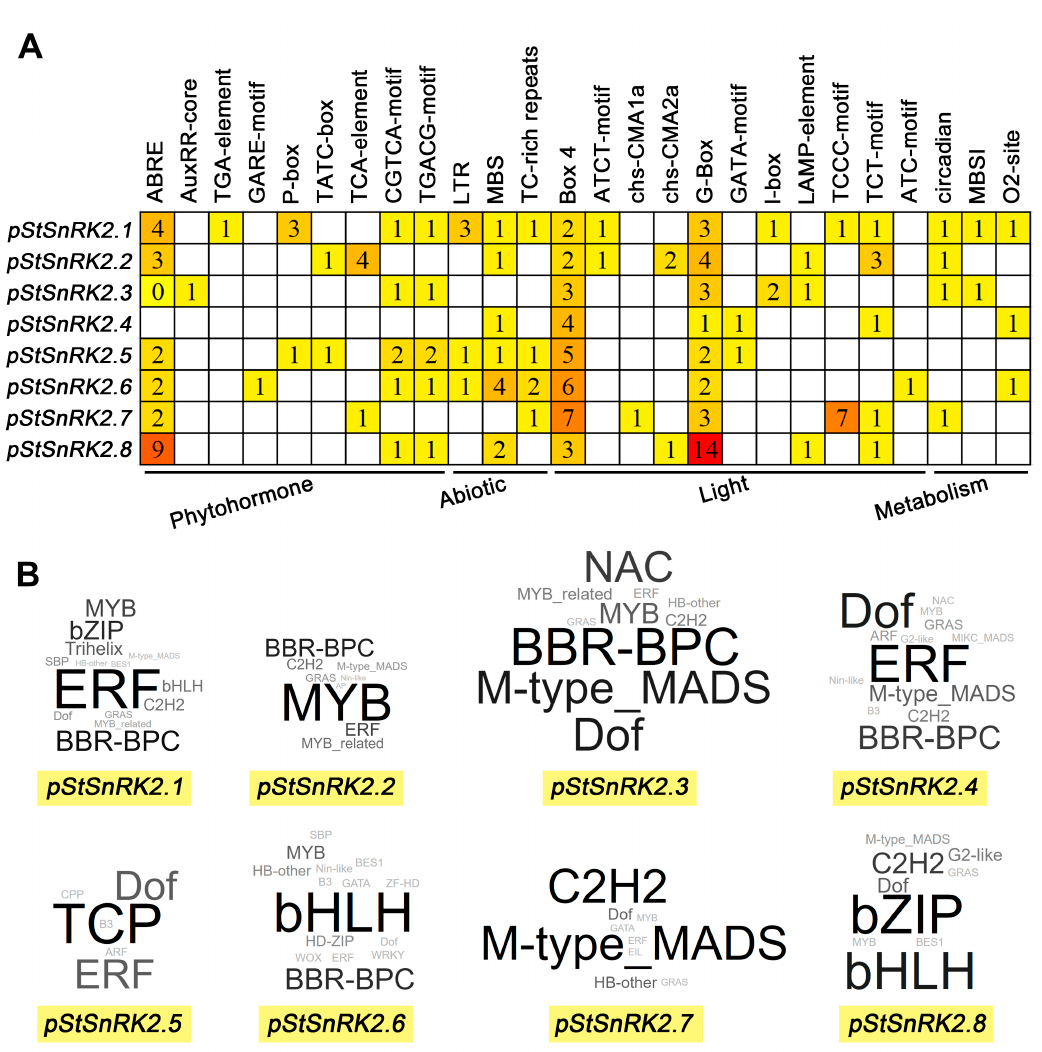
Figure 6. Predictive analysis of StSnRK2 gene promoter sequences. ( A ) The types and numbers of cis elements of StSnRK2 gene promoter sequences were analyzed by PlantCARE software. ( B ) Prediction of upstream regulatory proteins of the StSnRK2 gene. Different words represent different protein families. The word size represents the predicted frequency of the family of proteins.